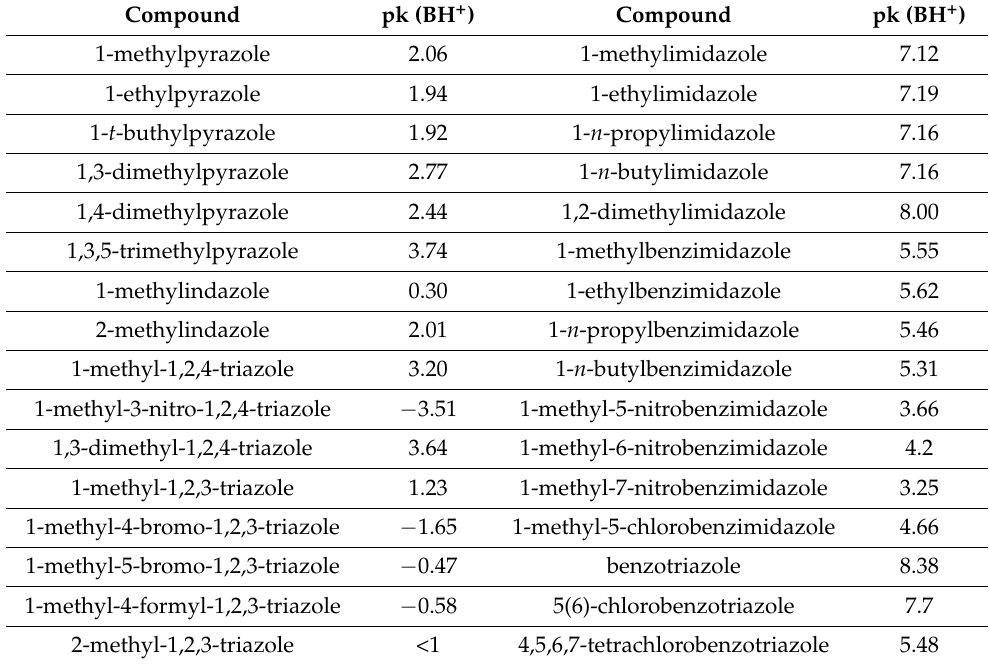
Table 1. The basicity of substituted